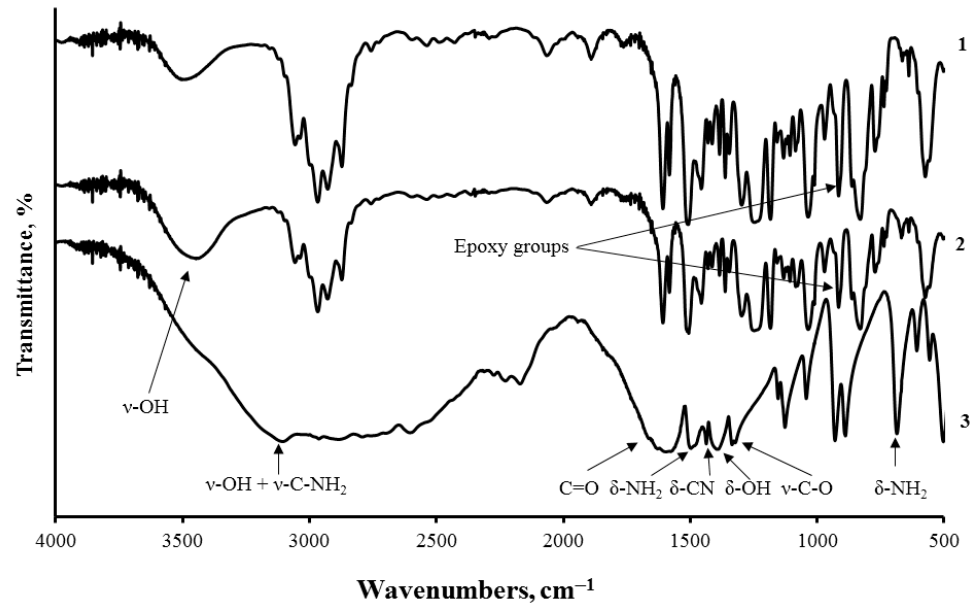
Figure 4. FT-IR spectroscopy of samples: 1—ED-20; 2—ED-20 + aminoacetic acid; 3—aminoacetic acid.